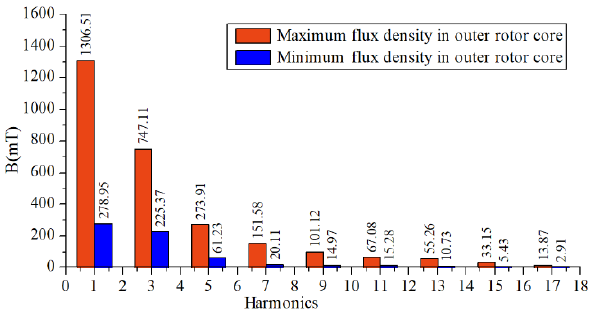
Figure 14. The maximum and minimum FFT values of the harmonics in the outer rotor core.